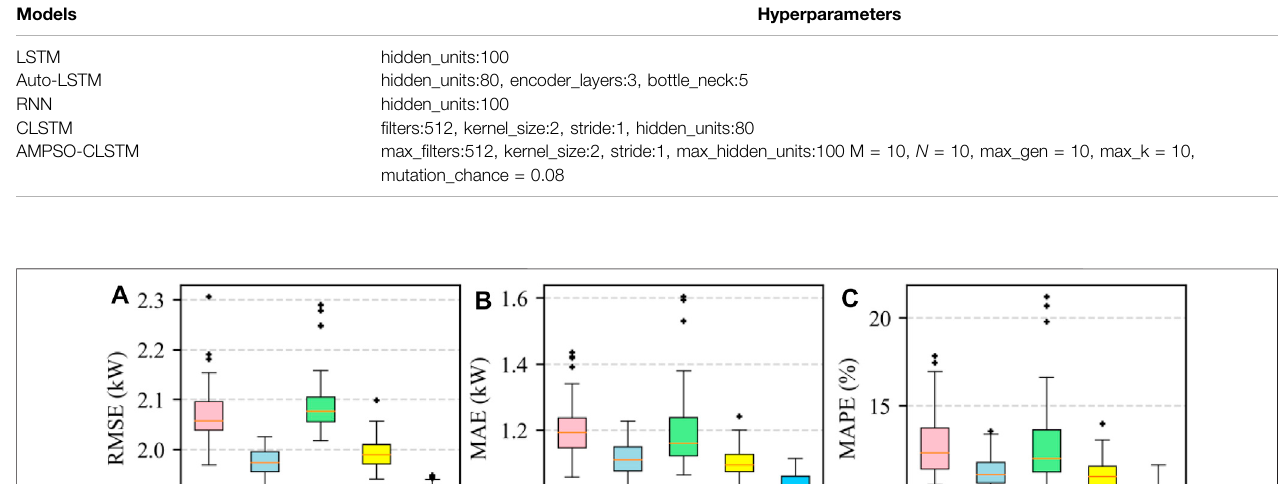
TABLE 2 | Hyperparameter settings in the proposed model. Models